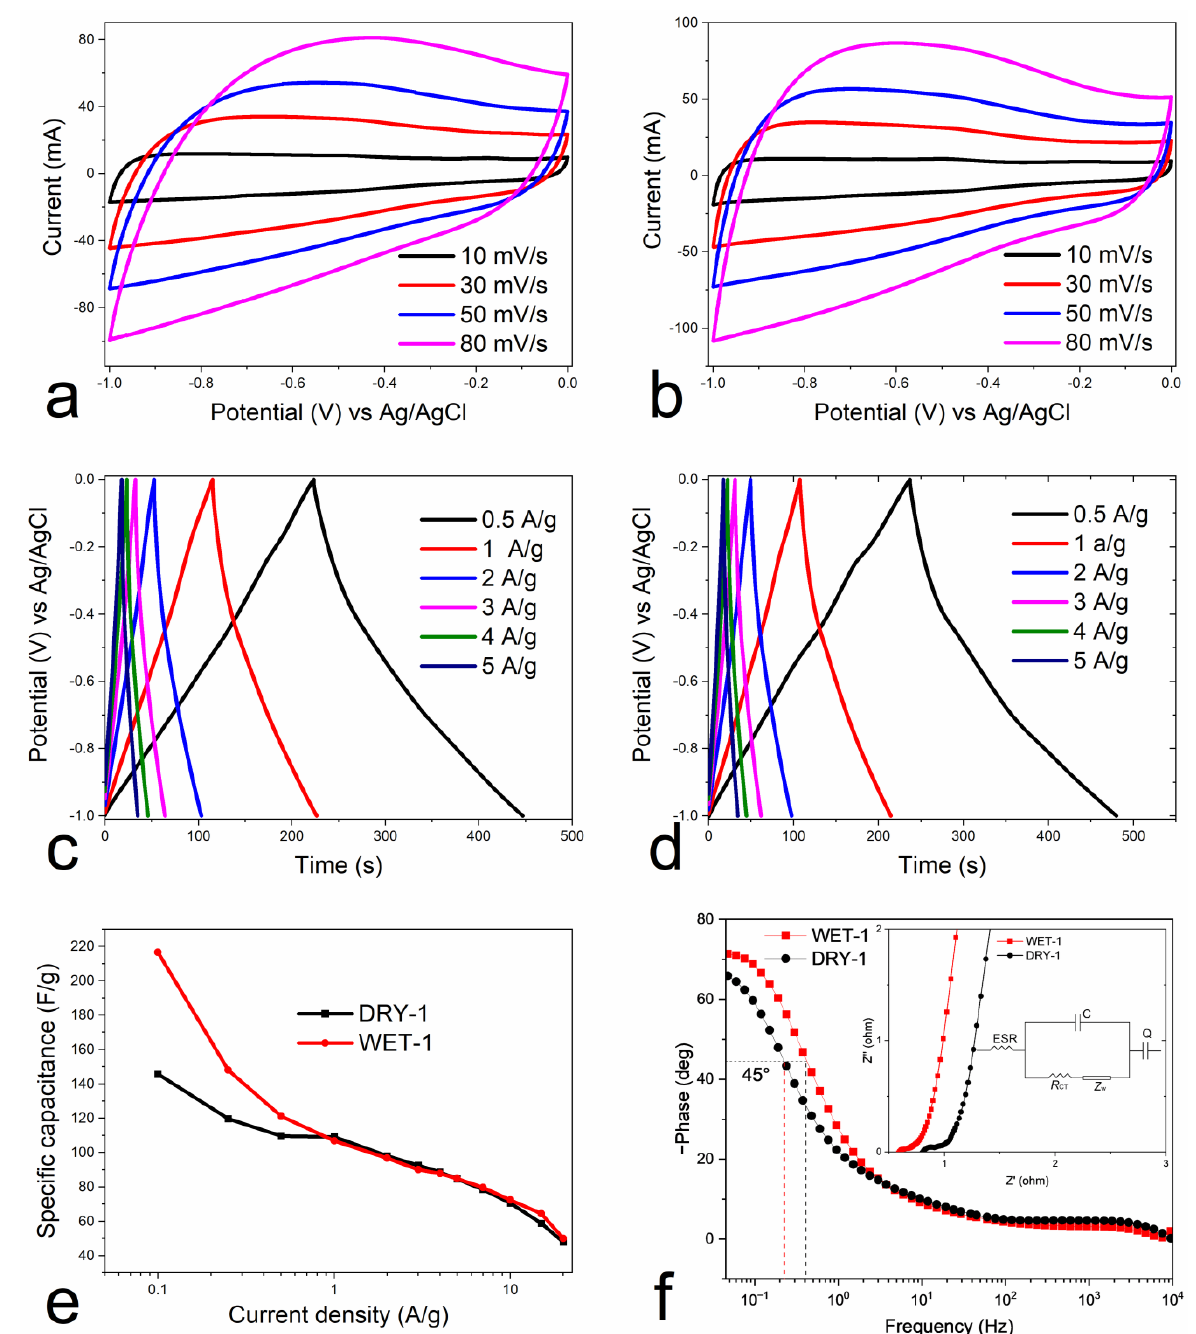
Figure 7. Electrochemical measurements: the CV curves of ( a ) DRY-1, ( b ) WET-1. Charge–discharge cycles of ( c ) DRY-1, ( d ) WET-1, ( e ) specific capacitance as a function of current density and ( f ) Bode plot and the inset showing the Nyquist plots with the equivalent circuit model.